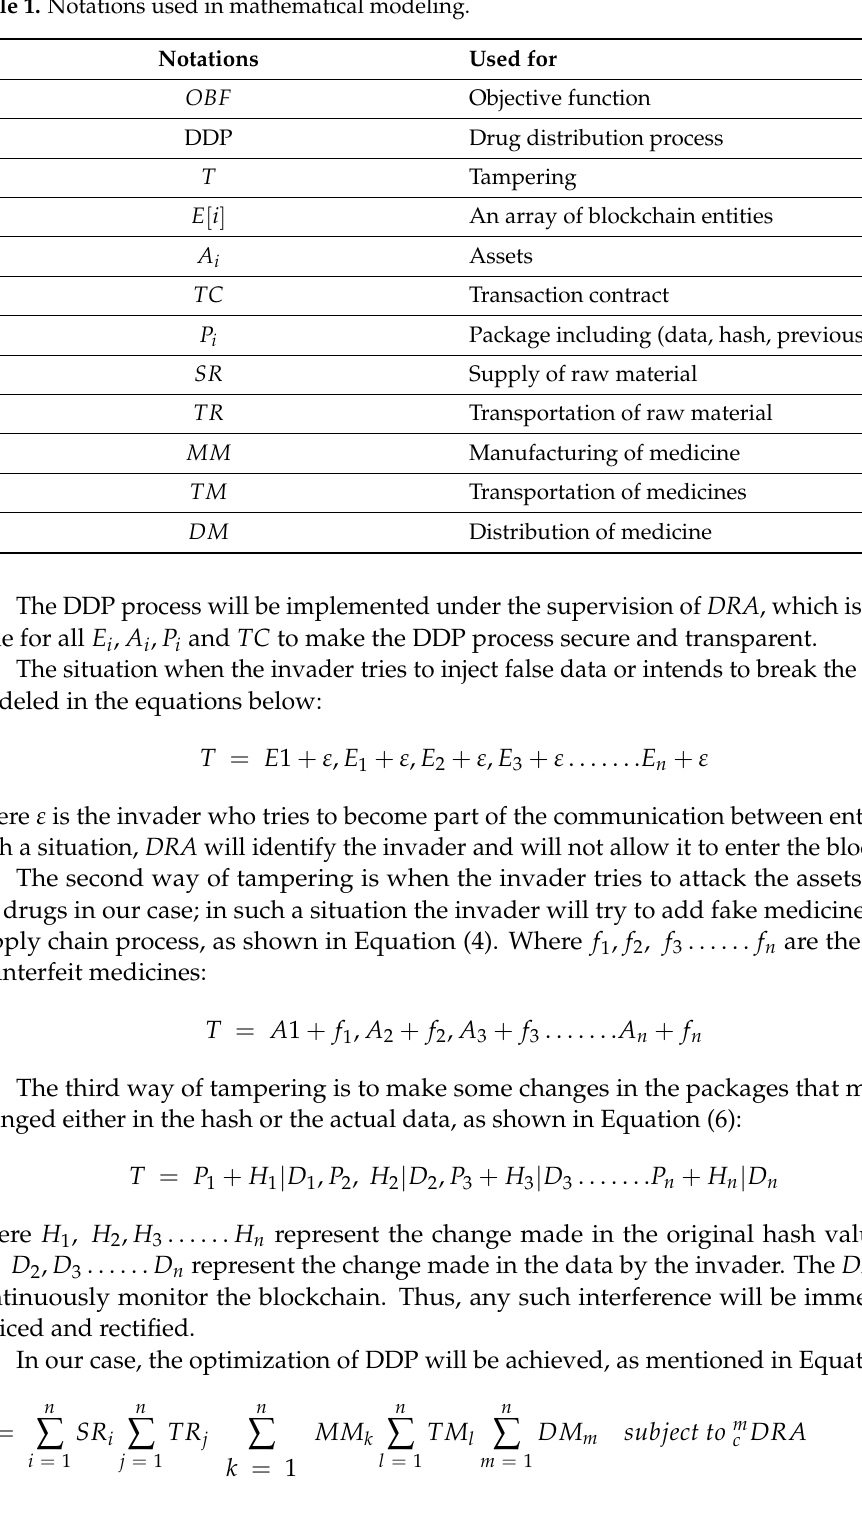
Table 1. Notations used in mathematical